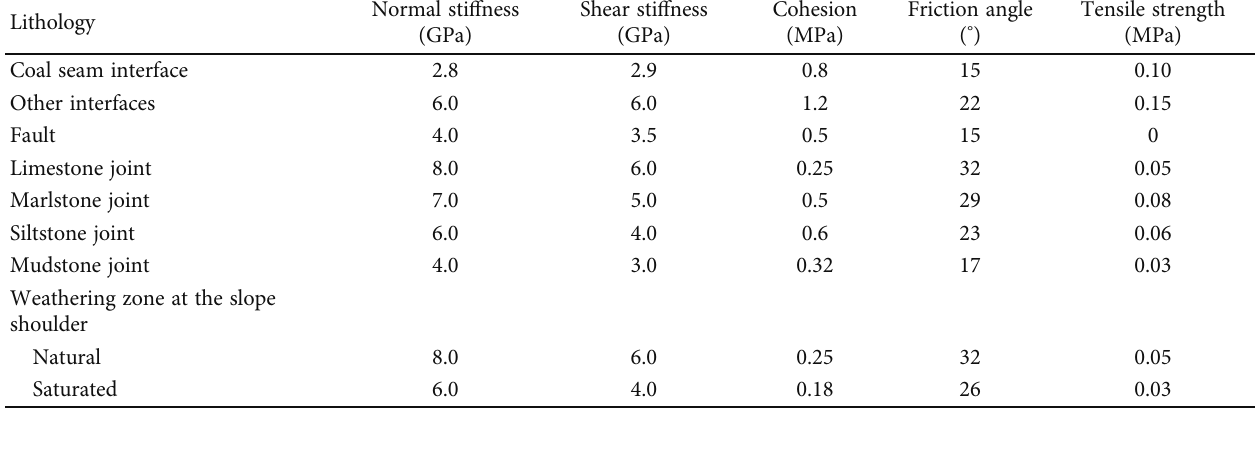
Table 3: Mechanical parameters of the discontinuity surface.